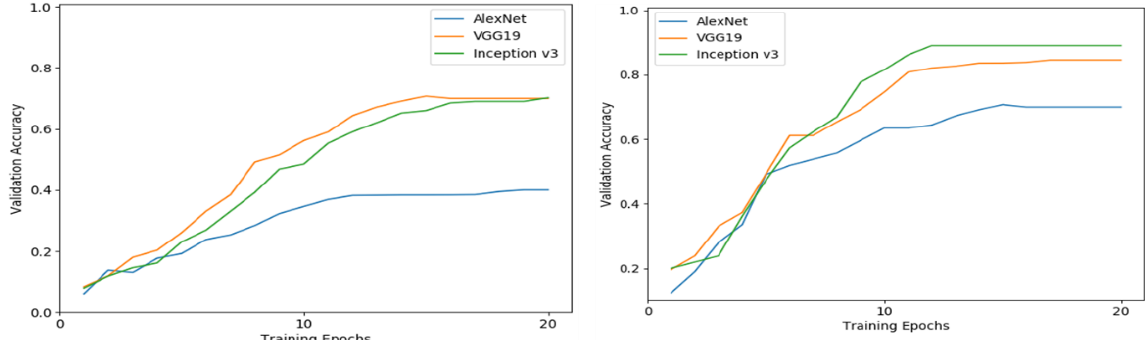
Figure 8. Validation accuracy in the different training epochs for the three different proposed deep